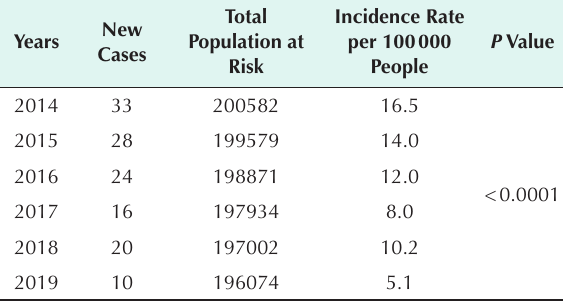
Table 1. The Incidence Rate of Cutaneous Leishmaniasis Per 100 000 Population in Izeh County (2014-2019)